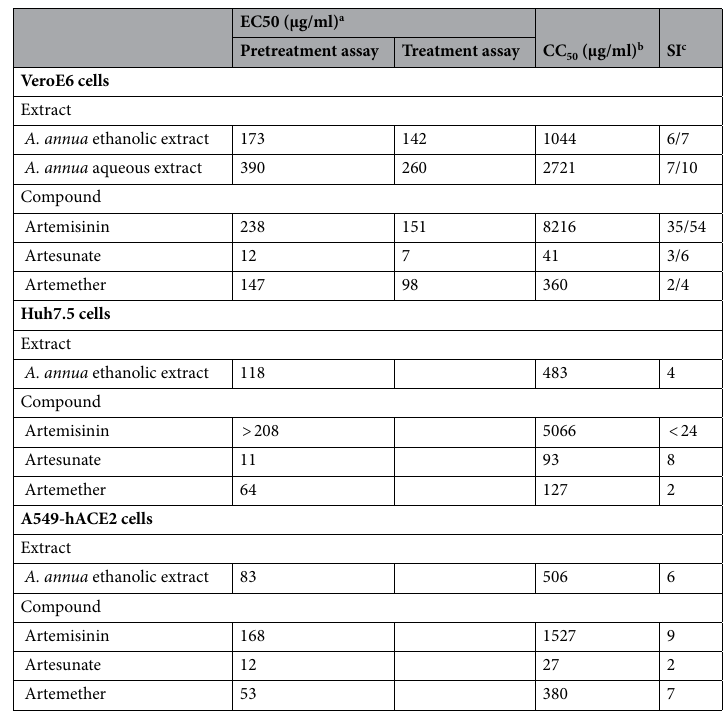
Table 1. Efficacy of extracts and compounds in vitro. a EC 50 , median effective concentration (µg/mL) was determined in VeroE6 cells in pretreatment or treatment antiviral assays or in Huh7.5 cells and A549-hACE2 cells in treatment antiviral assays as described in Material and Methods. For artemisinin in Huh7.5 cells, < 50% inhibition was observed at the highest non-cytotoxic concentration where cell viability was > 90% of that of non-treated control cultures. b CC 50 , median cytotoxic concentration (µg/mL) was determined as described in Material and Methods. c SI, selectivity index, was determined as CC 50 divided by EC 50 based on results in pretreatment/treatment antiviral assays in VeroE6 cells or based on results in treatment antiviral assays in Huh 7.5 cells and A549-hACE2